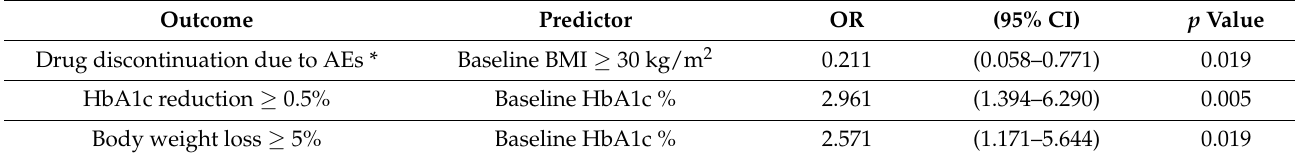
Table 4. Logistic regression analyses predicting safety and efficacy outcomes (i.e., drug discontinuation due to adverse events (AEs), HbA1c reduction ≥ 0.5%, body weight loss ≥ 5%) when using dulaglutide 1.5 mg/once weekly as add-on to MET or MET plus insulin